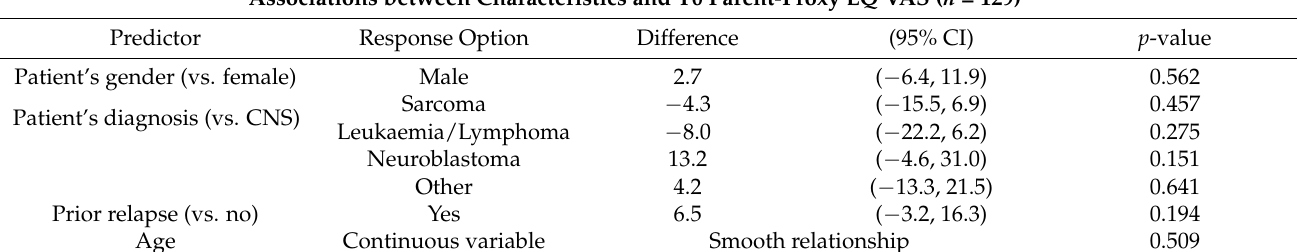
Figure 4. Boxplot distribution of T1 parent-proxy EQ-VAS scores, sorted by recommendations. Dots represent individual data points. Table 7. Estimated associations with parent-proxy EQ VAS at T0 ( n = 129) * and T1 ( n = 64) *. Associations between Characteristics and T0 Parent-Proxy EQ VAS ( n = 129)